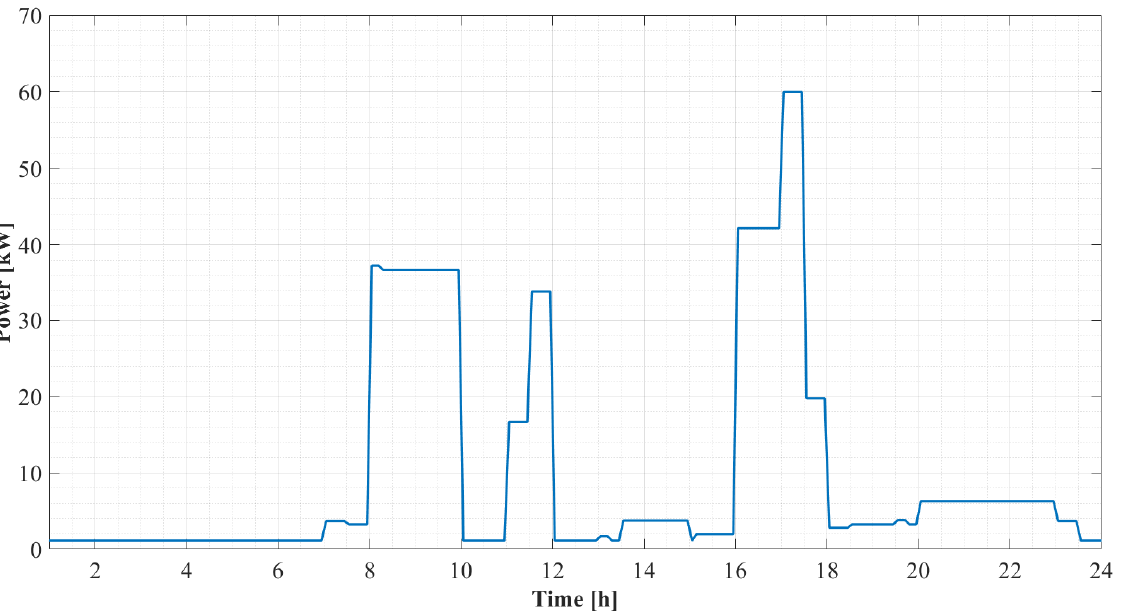
Figure 2. Layout of the system.